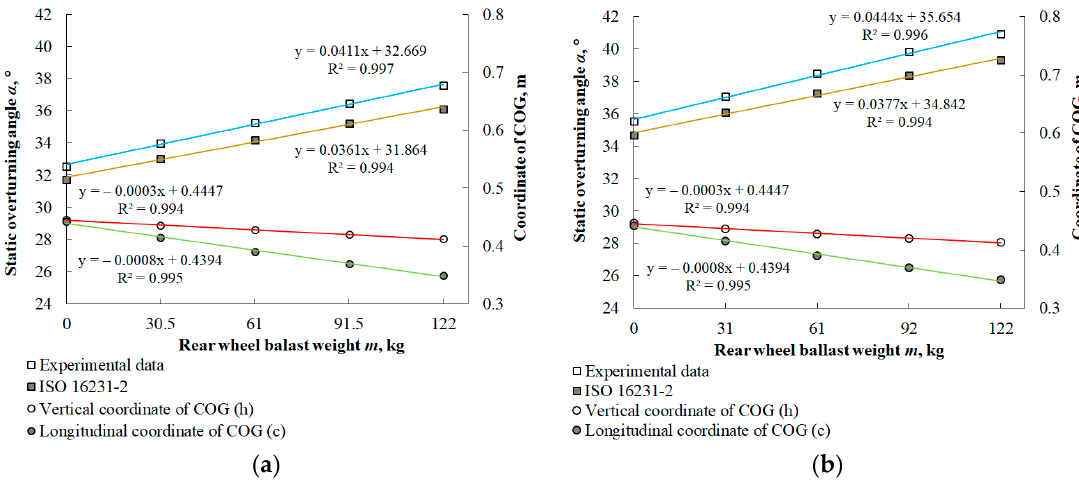
Figure 8. Static overturning angle and coordinates of COG: ( a ) standard overall width on tyres ( o = 0.795 m), ( b ) extended overall width on tyres ( o = 0.885 m).